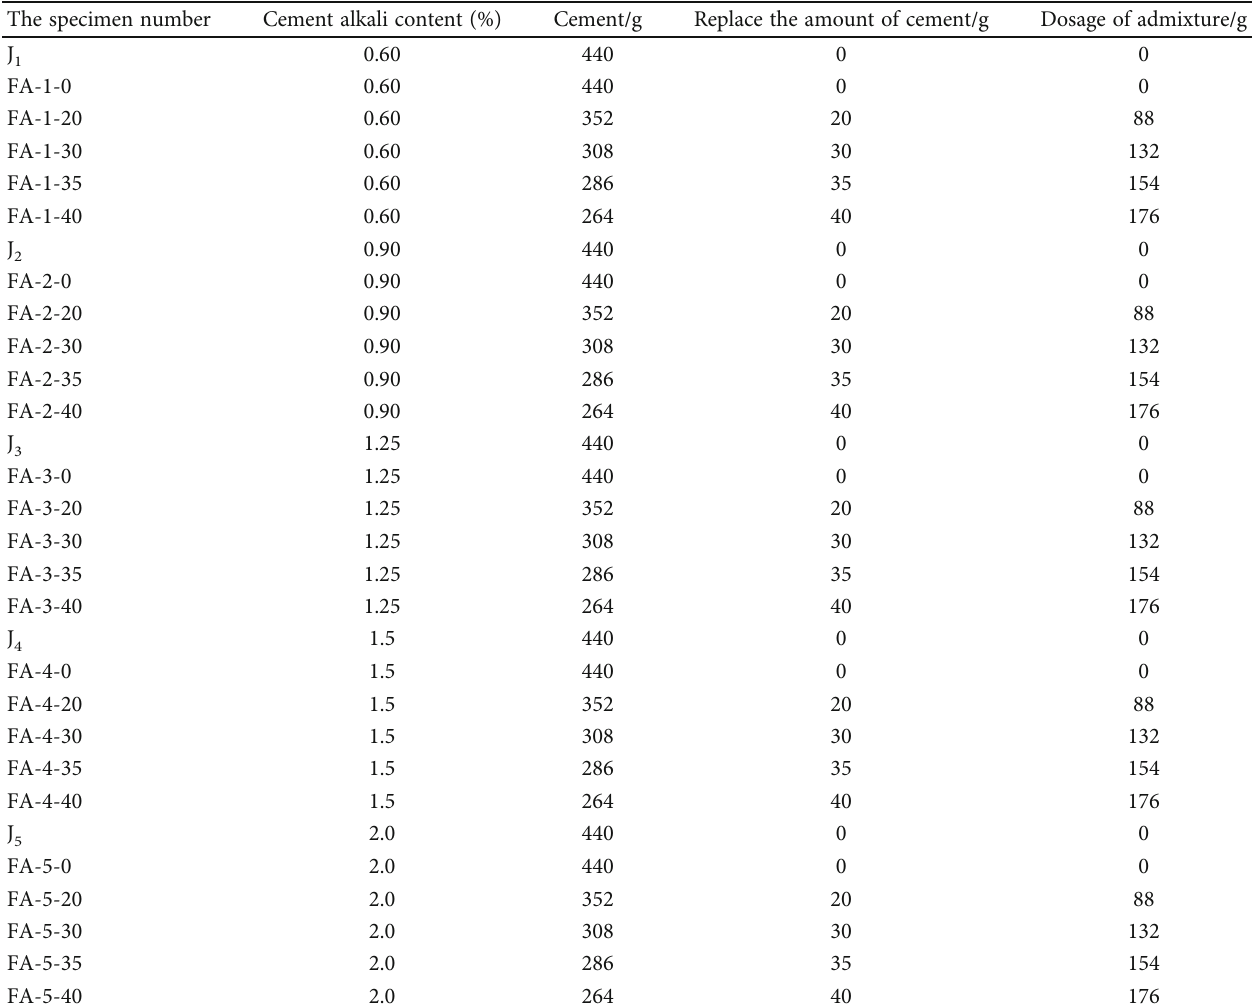
Table 4: The mating ratio of the mortar bar specimen.